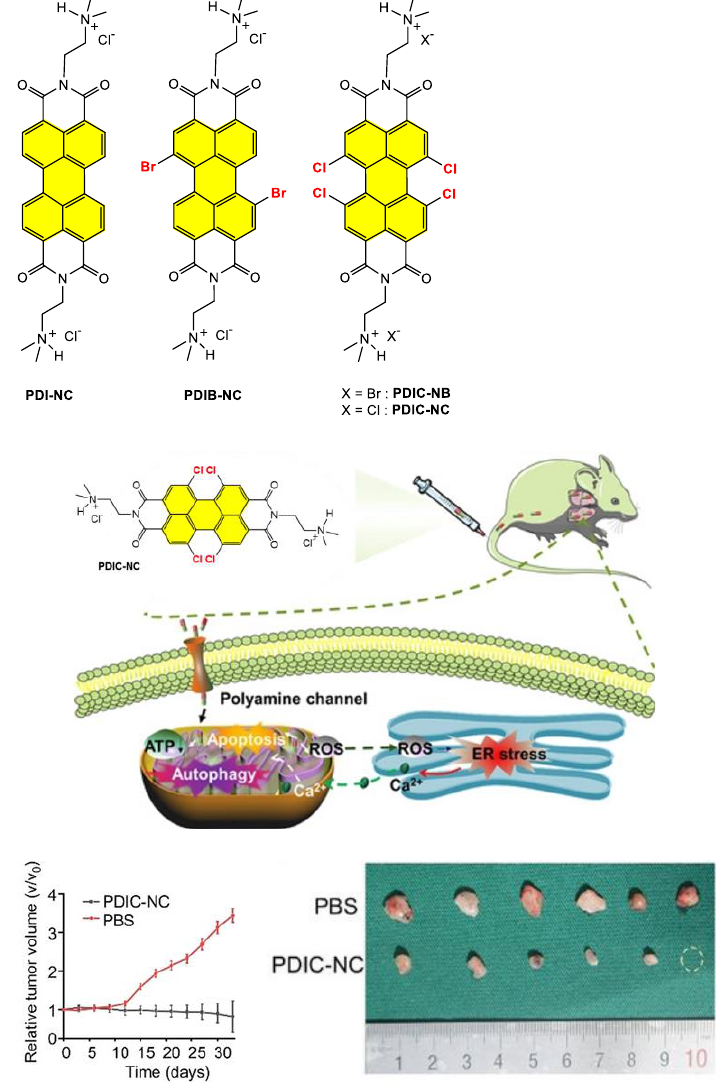
Figure 12. Structures of PDI-NC, PDIB-NC, PDIC-NB and PDIC-NC molecules; in vivo antitumour activity of PDIC-NC on a subcutaneous xenotransplanted tumour with the tumour tissue images in PBS and PDIC-NC treatment mice and relative tumour volume. Adapted with permission from reference [116]. Copyright 2021 Wiley-VCH GmbH.